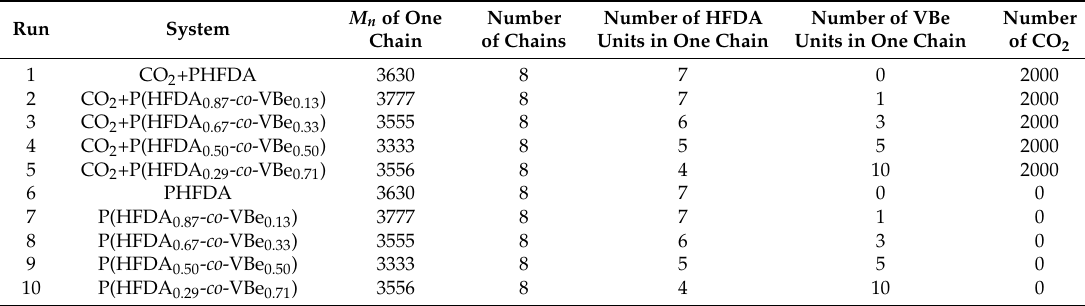
Table 1. The systems simulated by all-atom molecular dynamics.